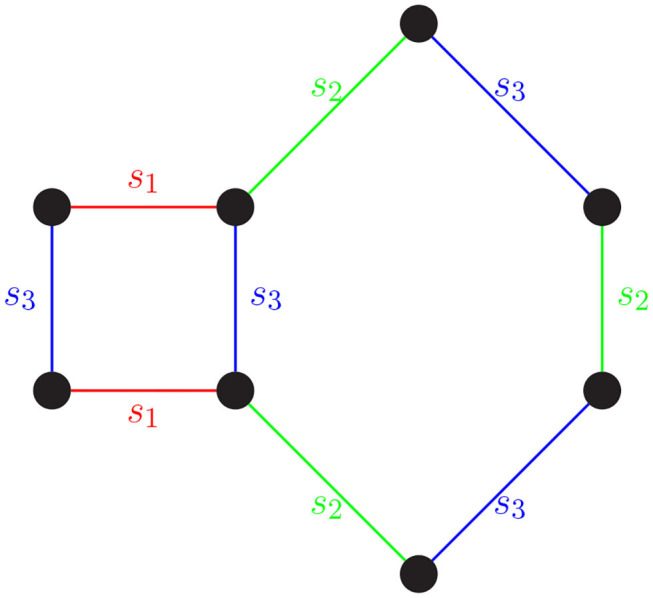
A word in S* that equals e can be rewritten using the relators in the group presentation and the group axioms. For instance, the word s1s2s3s2s3s2s1s3 = e in S4. Walking along an edge is equivalent to multiplying by a generator (edge label). Starting in the top left corner and tracing the word clockwise, we get the word s1s2s3s2s3s2s1s3. The closed path s1s2s3s2s3s2s1s3 is constructed using the relators s1s3s1s3 and s2s3s2s3s2s3.